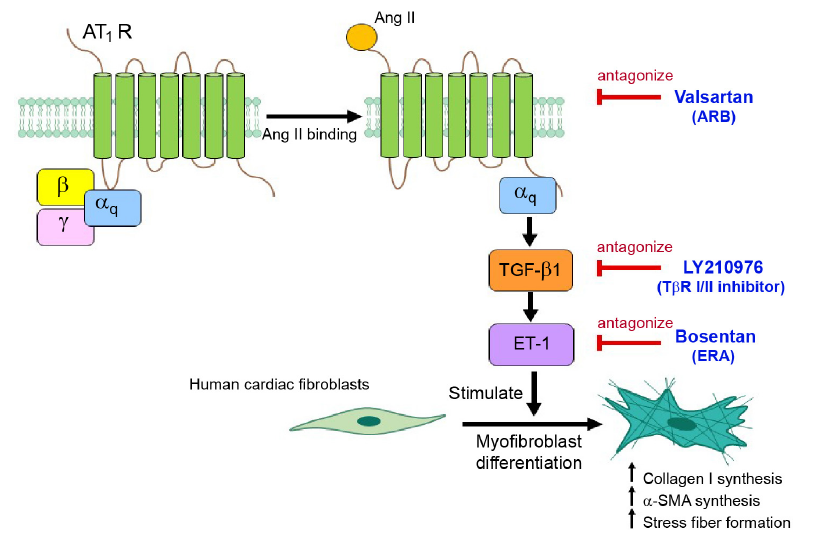
Figure 8. Schematic representing the TGF- β 1, ET-1 and Ang II networking on myofibroblast differentiation. In adult HCFs, Ang II stimulation of AT 1 Rs lead to an upregulation of TGF- β 1 and ET-1 and activation of their effectors through the AT 1 R/G α q axis. The activated AT 1 Rs transduce the signal through TGF- β 1 cascade, which in turn upregulates ET-1 through the Smad-dependent and ERK1/2-dependent pathways. The elevated ET-1 then binds to and activates ET A Rs, leading to increases in collagen I and α -SMA synthesis and stress fiber formation. Interestingly, antagonism of AT 1 Rs and dual blockade of TGF- β 1 receptors and ETRs exhibit antifibrotic effects by prevention and restoration of myofibroblast differentiation induced by Ang II. α -SMA: α -smooth muscle actin; Ang II: angiotensin II; AT 1 R: angiotensin II receptor type 1; ARB: angiotensin II receptor blocker; ET-1: Endothelin-1; ERAs: endothelin receptor antagonists; T β R I/II: TGF- β receptor type I and